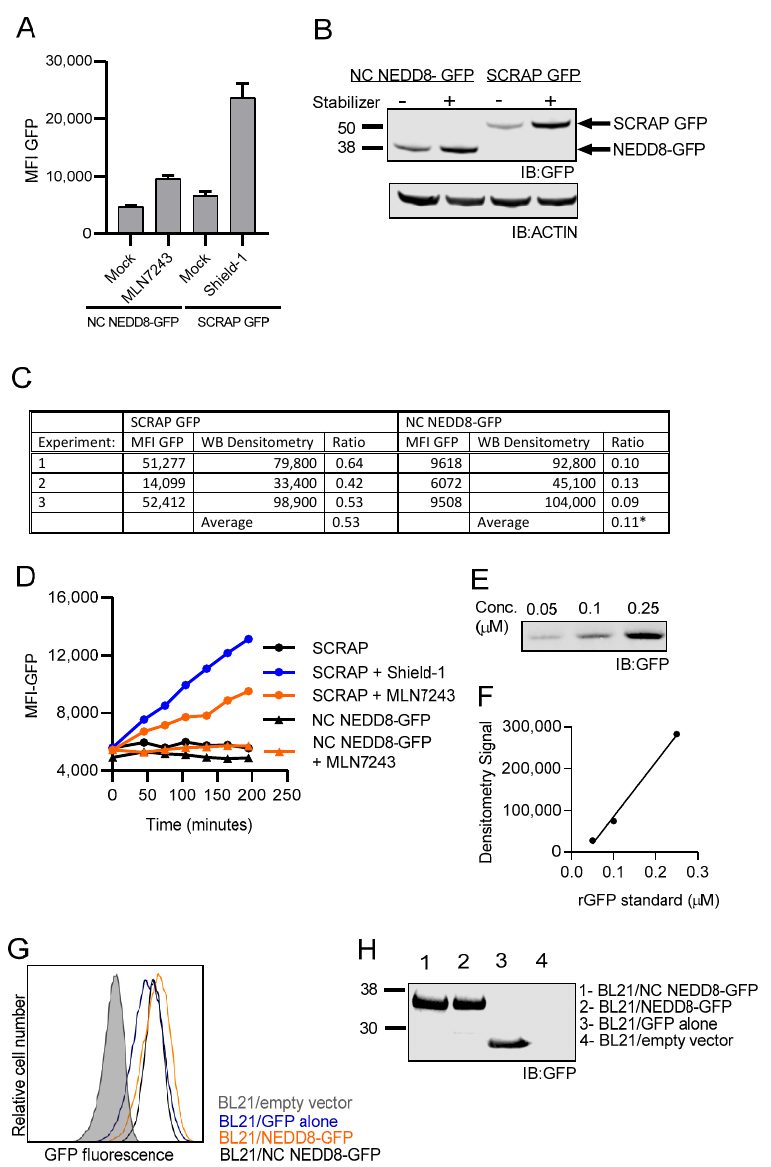
Figure 6. Fusion of NEDD8 to GFP prevents proper folding of GFP. ( A ) GFP fluorescence as determined by flow cytometry in EL4/NC NEDD8-GFP cells and EL4/SCRAP-GFP cells after treatment with chemical stabilizer (Shield-1 or MLN7243 respectively) for 3 h is shown. The average MFI of the cellular population from three independent measurements is reported on the y -axis. ( B ) Western blot analysis for GFP accumulation after treatment of EL4/NC NEDD8-GFP and EL4/SCRAP-GFP cells with their stabilizers, Shield-1 or MLN7243, respectively, for 3 h. ( C ) The ratio of fluorescent GFP signal obtained by flow cytometry (MFI GFP) to total GFP protein obtained by Western blot (WB Densitometry) for both SCRAP-GFP and NC NEDD8-GFP after treatment with stabilizer was calculated for three independent experiments and was statistically different (* p < 0.05). ( D ) Comparison of increased fluorescence of EL4/SCRAP-GFP cells and EL4/NC NEDD8-GFP cells after stabilizer treatment. Mean GFP fluorescence intensity of EL4/SCRAP-GFP cells (black circle), EL4/SCRAP-GFP cells treated with Shield-1 (blue circle) or MLN7243 (orange circle), and EL4/NC NEDD8-GFP (black triangle) and EL4/NC NEDD8-GFP treated with MLN7243 (orange triangle) were measured by flow cytometry at the indicated time points. ( E ) Representative Western blot of GFP standards with the concentration of recombinant GFP standard indicated. ( F ) Standard curve for the Western blot shown, ( E ) demonstrating the linearity of the signal determined by densitometry. ( G ) GFP fluorescence of E. coli expressing NC NEDD8-GFP (black trace), NEDD8-GFP (orange trace), GFP (blue trace), or empty cloning vector (shaded histogram) as determined by flow cytometry. ( H ) Western blot for GFP from the indicated cell lysates of E. coli from part (G) above. All Western blot images were cropped to show relevant